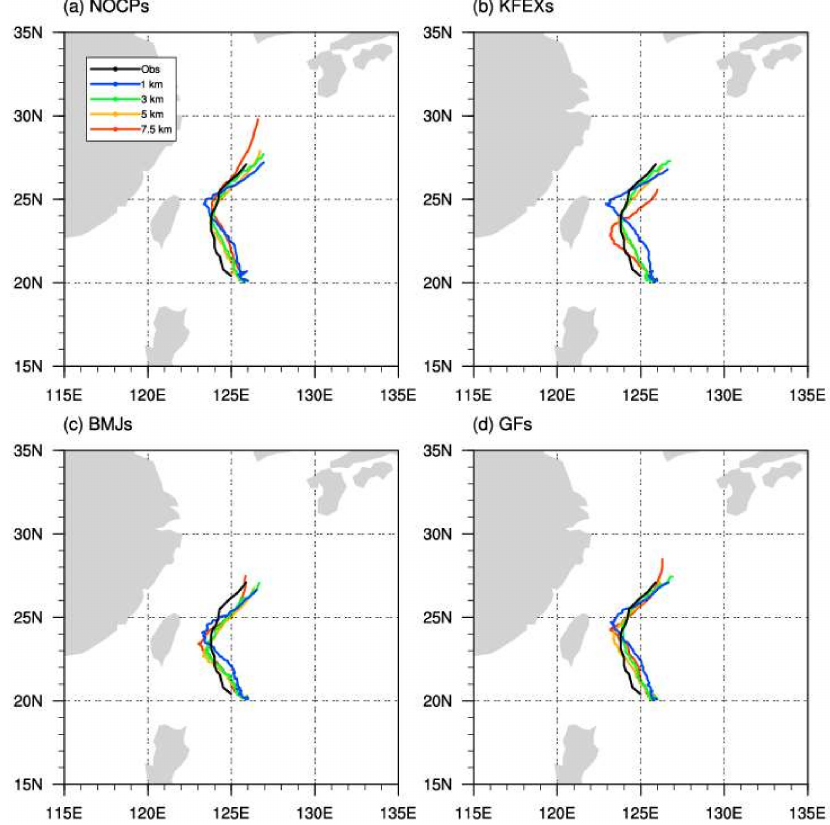
Figure 1. Storm tracks at various resolutions simulated by ( a ) NOCPs, ( b ) KFEXs, ( c ) BMJs, ( d ) GFs. The black line is the observation data from